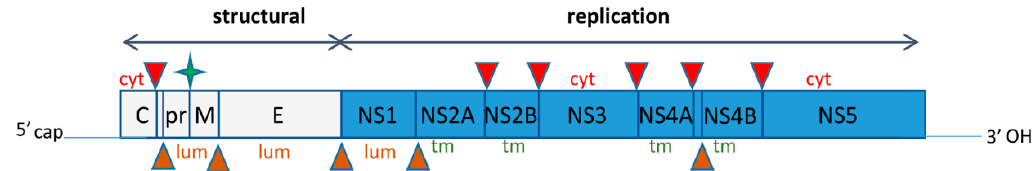
Figure 1. Scheme of Zika virus genome. The distribution of individual peptides and cleavage sites relative to the ER membrane are indicated. Cyt—cytoplasmic side, lum, -luminal side, tm—transmembrane. Red triangles designate cleavages performed by the viral protease complex NS2B-NS3 on the cytoplasmic side of the ER; brown triangles indicate cleavages performed by cellular proteases inside the ER lumen; green star shows final maturation cleavage of M glycoprotein performed by the Golgi-resident protease furin.